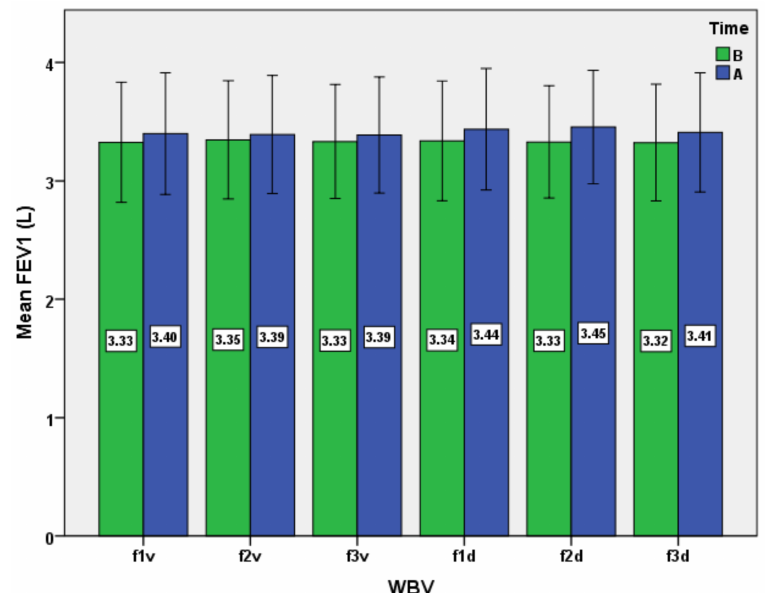
Figure 5. Impact of the WBV exposure on forced expiratory volume at 1 s (FEV 1 ) for the six protocols (means and standard deviations). B, before; A,